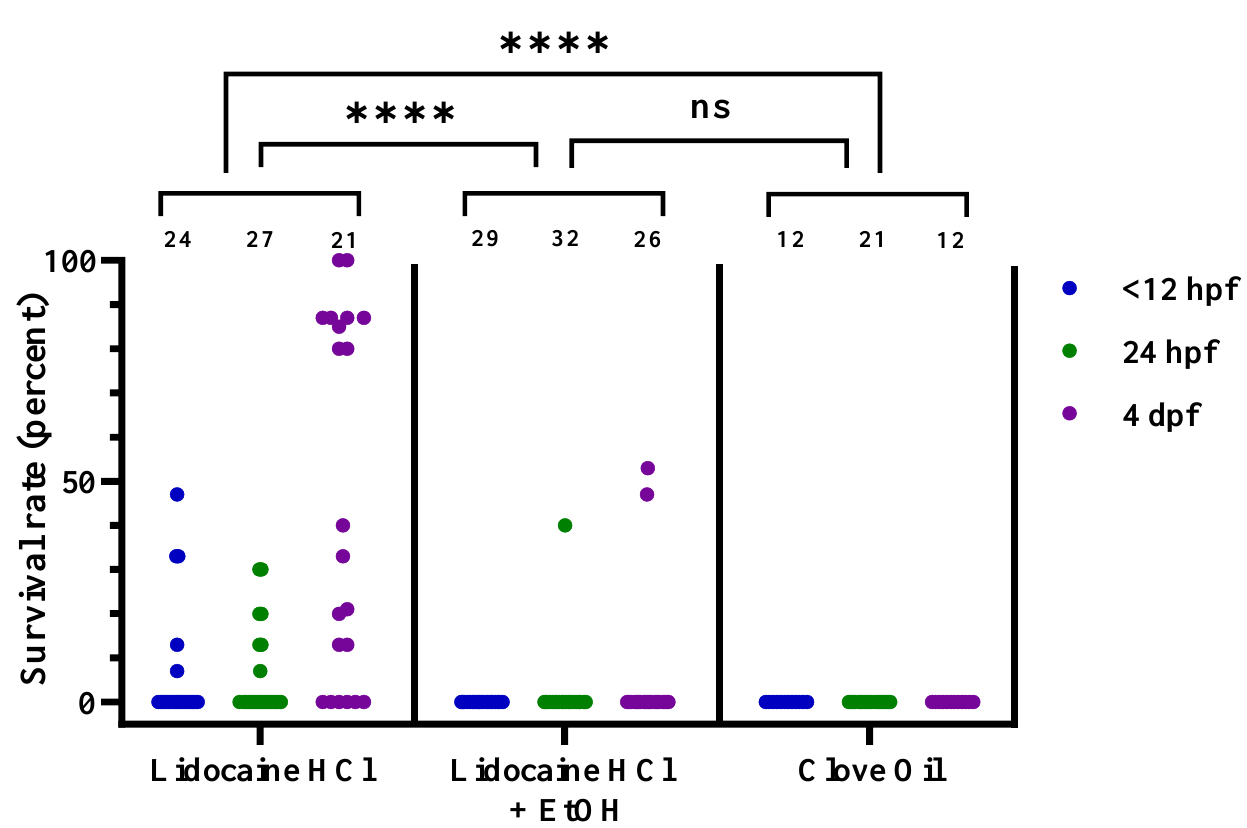
Figure 5. Survival rates for zebrafish following lidocaine hydrochloride (HCl), lidocaine HCl with ethanol (EtOH), or clove oil treatment, at 3 different developmental stages (<12 hpf, 24 hpf, and 4 dpf), presented as result per dish. Each dot represents one dish, with the total number of dishes per group indicated at the top of each column ( n = 12 – 32). Statistical difference between the treatments was assessed by the chi-squared test ( p < 0.0001), with post hoc analysis using Fisher’s exact test; ****; p < 0.0001. Note that the statistical analyses were performed on passed/failed dish frequencies (see Table 4 for details) and not on the continuous data presented here. ns; no statistical significance ( p = 0.2987). hpf; hours post fertilization. dpf; days post fertilization.